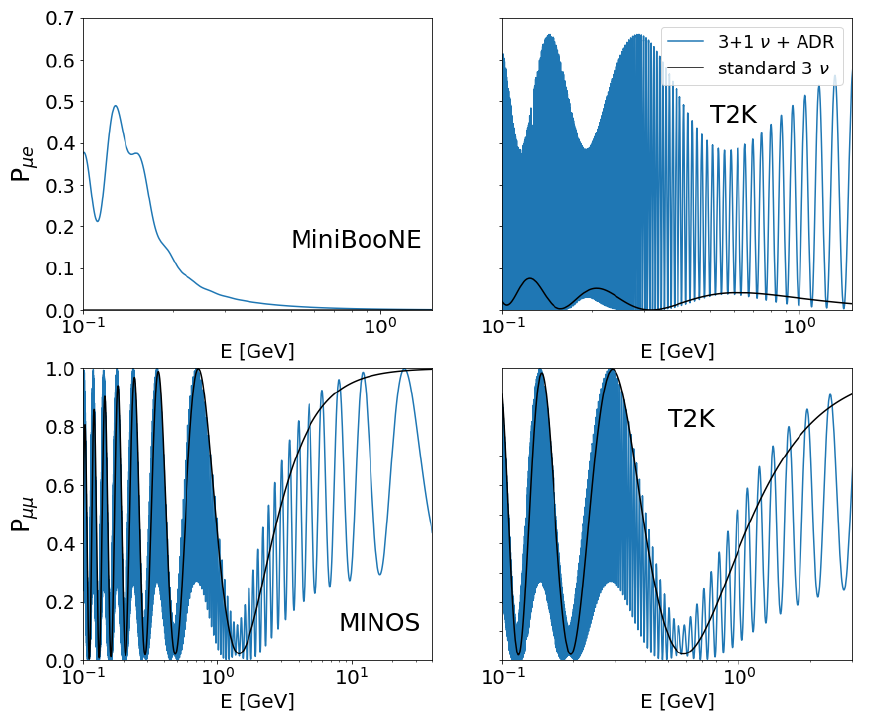
Figure 3 . Comparison between the predictions of the three neutrino standard picture and a 3+1 model with altered dispersion relations with (cid:15) = 5 (cid:2) 10 (cid:0) 17 . The upper panels show the appearance probability at MiniBooNE ( L = 0 : 541 km) (left) and T2K ( L = 295 km) (right), while the lower panels show the disappearance probability at MINOS ( L = 731 km) (left) and T2K ( L = 295 km)